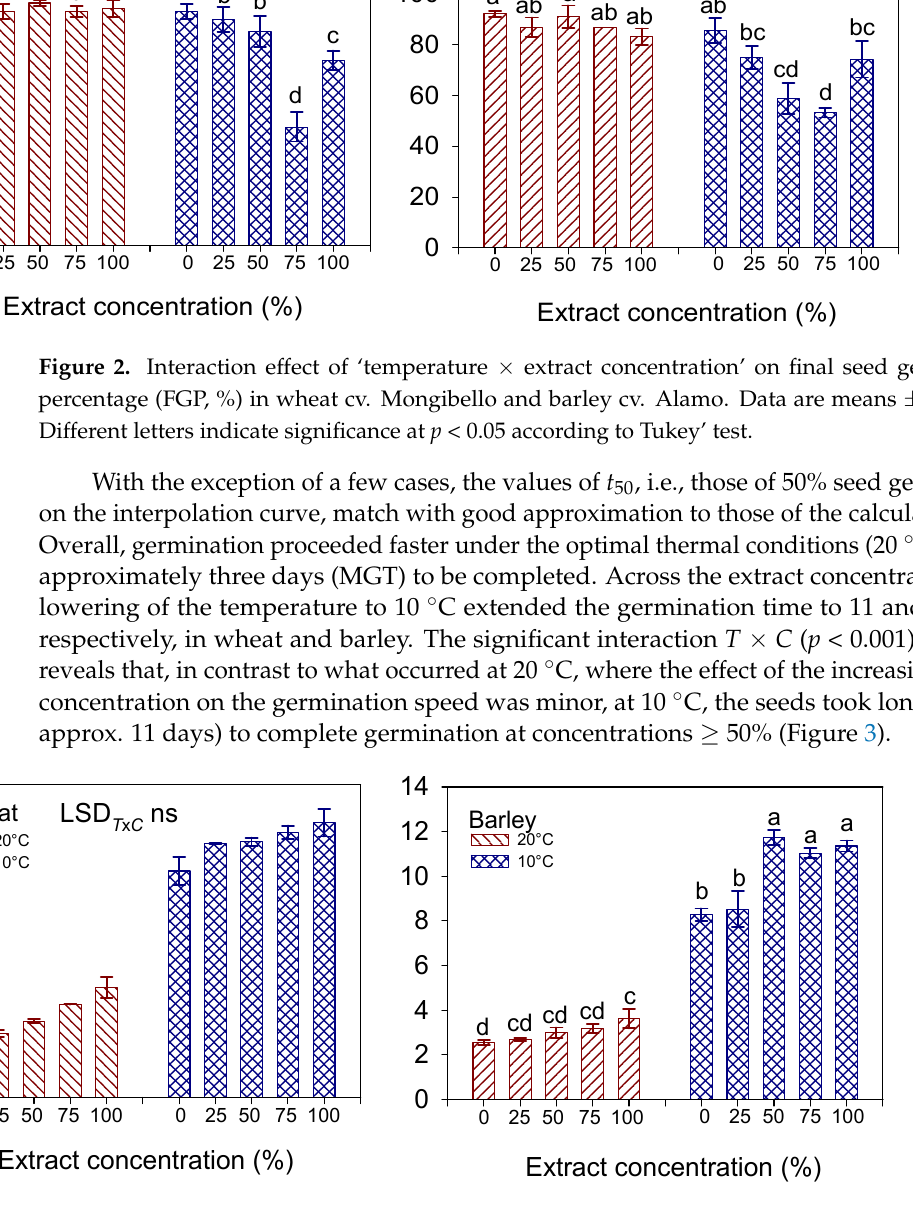
Figure 3. Interaction effect of ‘temperature × extract concentration’ on mean germination time (MGT, days) in wheat cv. Mongibello and barley cv. Alamo. Data are means ± se ( n = 4). Different letters in barley indicate significance at p < 0.05 according to Tukey’ test ( T × C wheat, not significant- ns ).